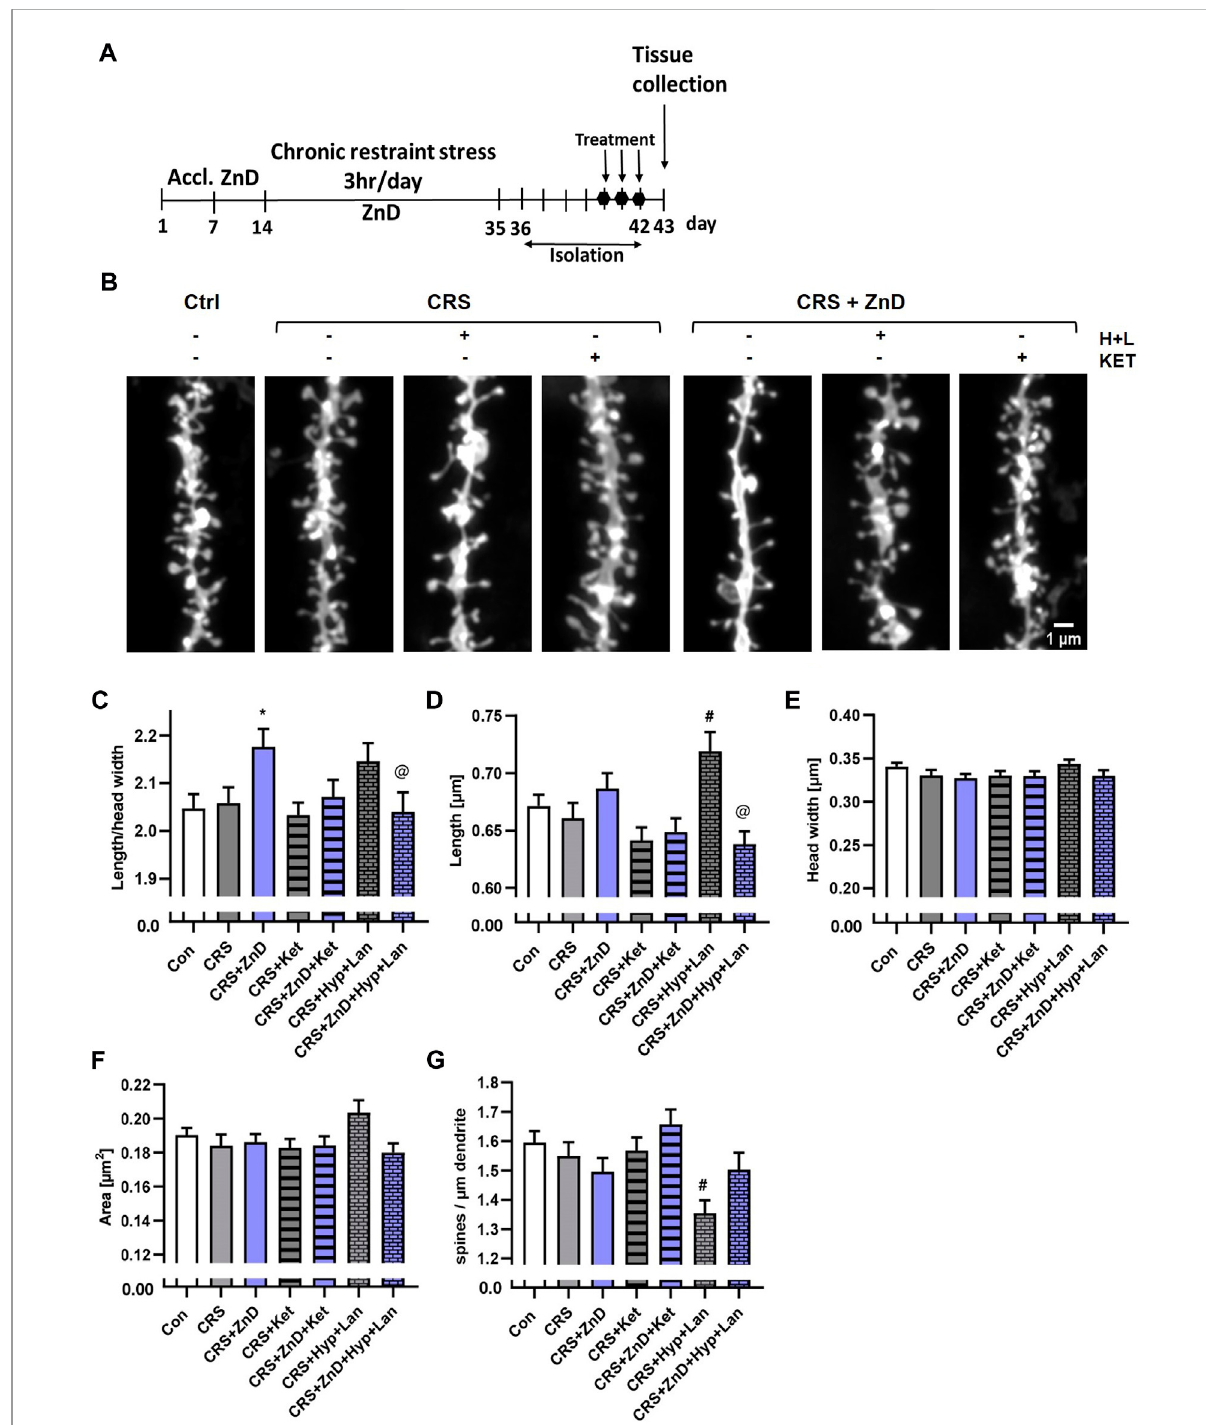
FIGURE 5 Effectsofthreedosesofatypicalantidepressantcompounds(ketamineandHyp+Lan)onthemorphologiesanddensitiesofdendriticspinesin the Hp in mice subjected to CRS, or CRS + ZnD. (A) Experimental schedule. (B) Representative confocal images of DiI-stained dendrite fragments. Changes in the shape and density of spines in the (C) Hp of mice. All values are expressed as mean ± SEM. The data were analyzed by (C – F) Kruskal – WallistestfollowedbyDunn ’ smultiplecomparisontestor (G) one-wayANOVAfollowedbySidak ’ smultiplecomparisontest.* p < 0.05 vs Con, @ p < 0.05 vs CRS + ZnD, # p < 0.05 vs CRS. Hp: [ morphology : Con: n mice = 5, n dendrites = 76, n spines = 6286; CRS: n mice = 5, n dendrites = 60, n spines = 4760; CRS + Hyp + Lan: n mice = 4, n dendrites = 44, n spines = 3297; CRS + Ket: n mice = 4, n dendrites = 67, n spines = 5064;CRS